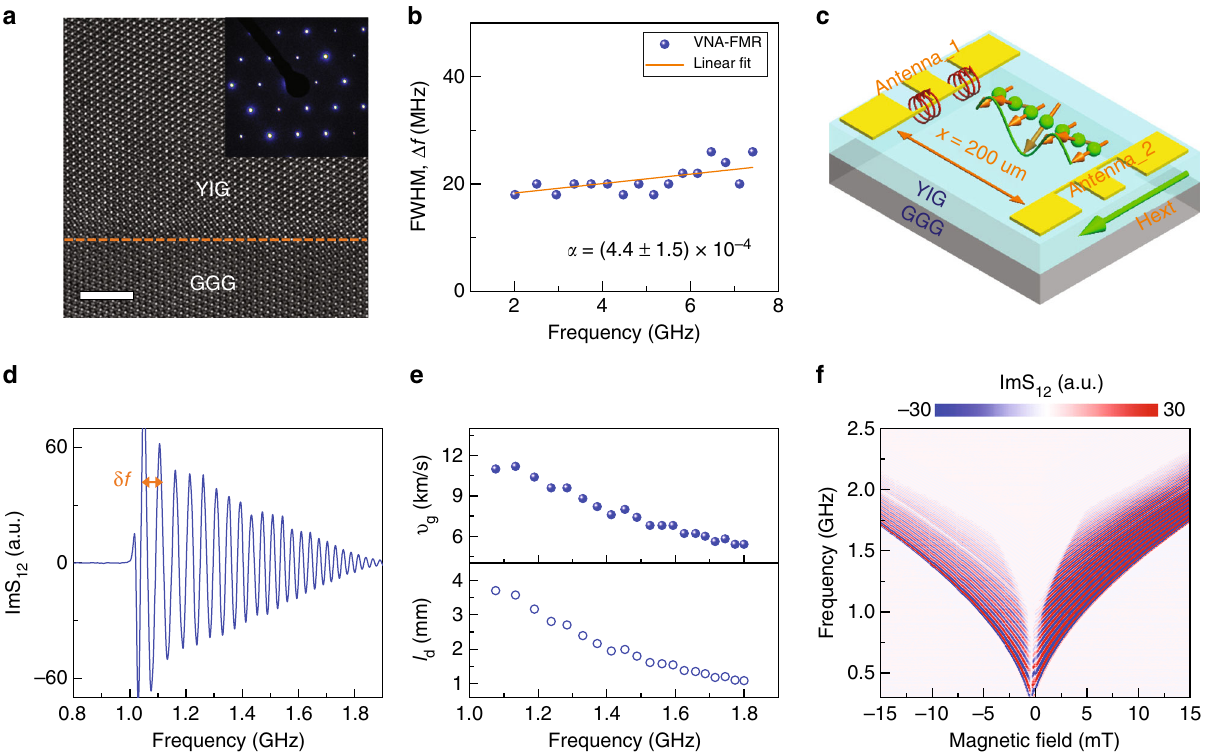
Fig. 1 Properties of continuous nanometer-thick YIG fi lms. a High-resolution TEM image and corresponding diffraction pattern of a 260-nm-thick YIG fi lm. The dashed line indicates a sharp interface between the GGG(111) substrate and single-crystal YIG fi lm. The white scale bar corresponds to 5 nm. b Linewidth of VNA-FMR spectra as a function of frequency. The data are obtained by variation of the external magnetic bias fi eld. c Schematic of the broadband spin-wave spectroscopy measurement geometry. d Spin-wave transmission spectrum (imaginary part of S 12 ) for a continuous 260-nm-thick YIG fi lm at a magnetic bias fi eld of 5 mT. e Spin-wave group velocity ( υ g ) and decay length ( l d ) in YIG. f Imaginary part of S 12 at different external magnetic bias fi (orange line) and with (green line) CoFeB in the grooves. During